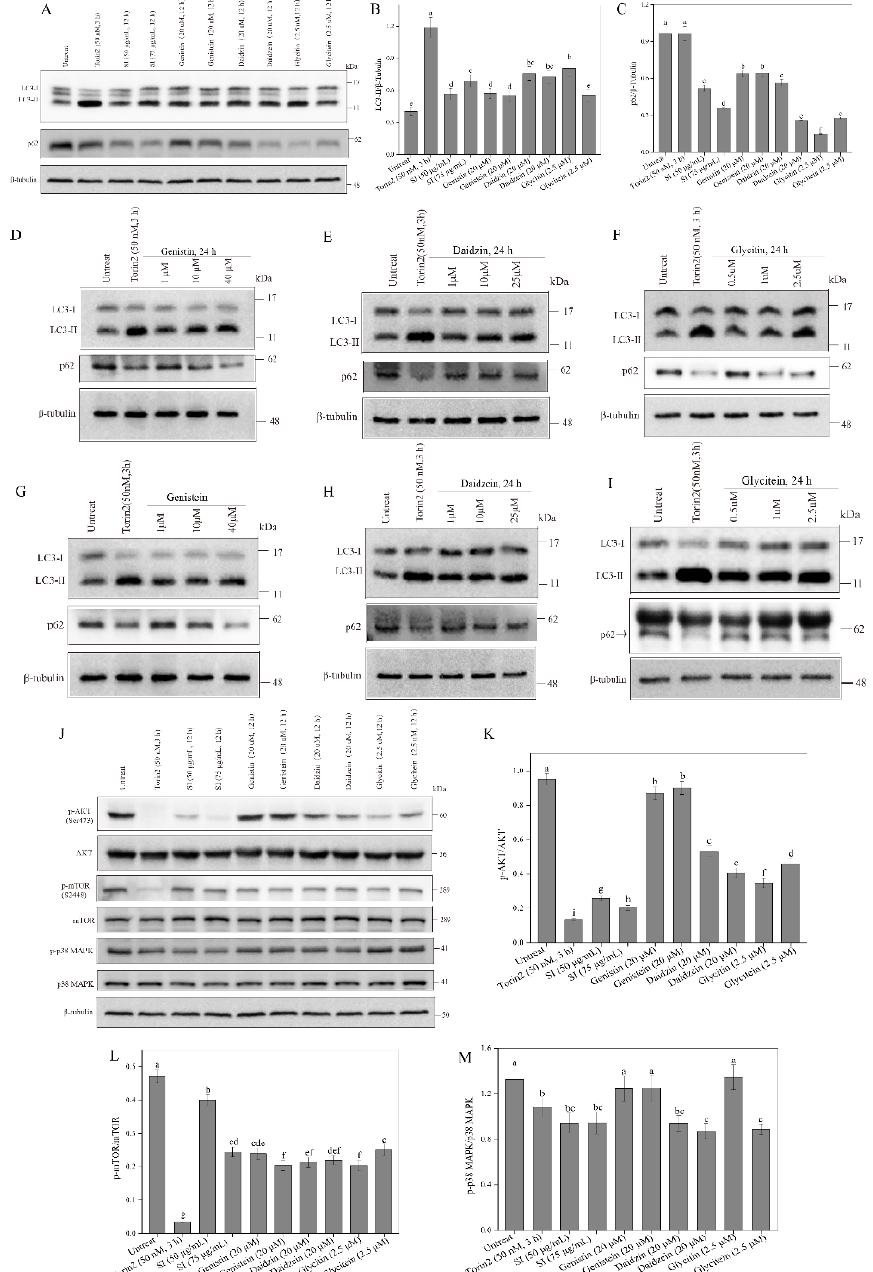
Figure 7. Effects of isoflavones on p38 MAPK pathway and autophagy. ( A ) Effects of isoflavones on autophagy. ( B ) The relative expression level of LC3-II protein in ( A ). ( C ) The relative expression level of p62 protein in ( A ). ( D ) Effects of genistin treatment at different concentrations on autophagy. ( E ) Effects of daidzin treatment at different concentrations on autophagy. ( F ) Effects of glycitin treatment at different concentrations on autophagy. ( G ) Effects of genistein treatment at different concentrations on autophagy. ( H ) Effects of daidzein treatment at different concentrations on autophagy. ( I ) Effects of glycitein treatment at different concentrations on autophagy. ( J ) Western blot analysis of mTOR-AKT and p38 MAPK pathway. ( K ) The phosphorylation of AKT protein. ( L ) The phosphorylation of mTOR protein. ( M ) The phosphorylation of p38 MAPK. Means with different small letters were significantly different ( p < 0.05).